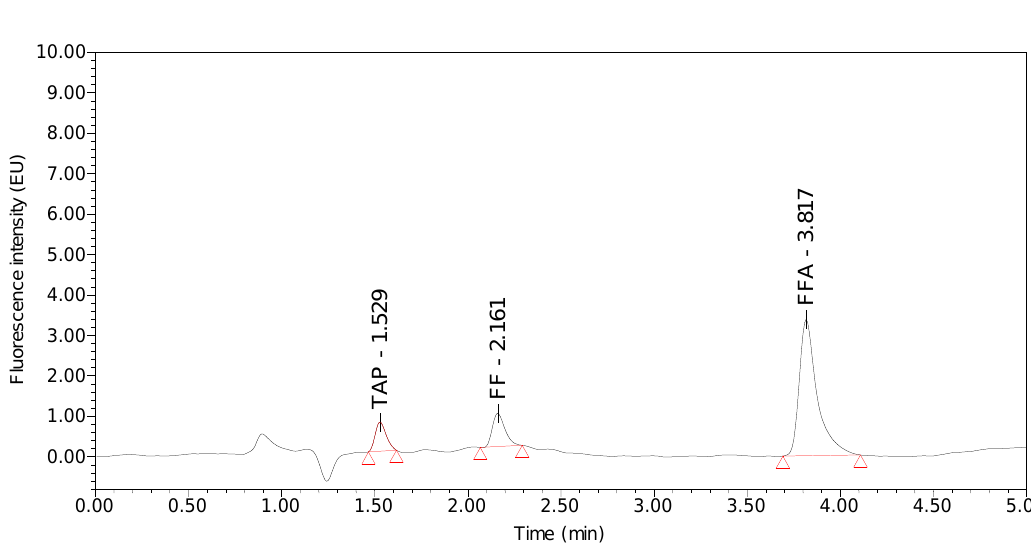
Figure 5. Chromatogram of the blank hen egg. Figure 6. Chromatogram of the blank hen egg spiked with 25 µg/kg TAP and 50 µg/kg FF and FFA standards.